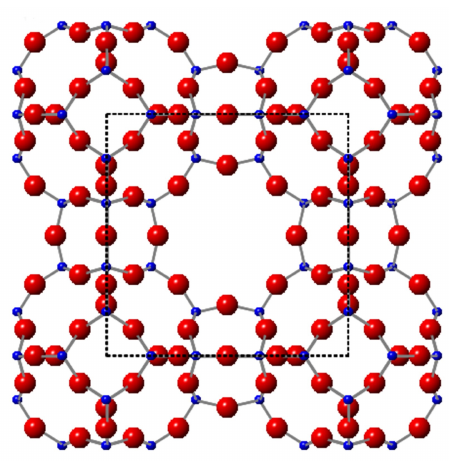
Figure 1. Linde Type A (LTA) framework with the α cage as the unit cell in the middle (black square). Red spheres: oxygens; blue: Si/Al